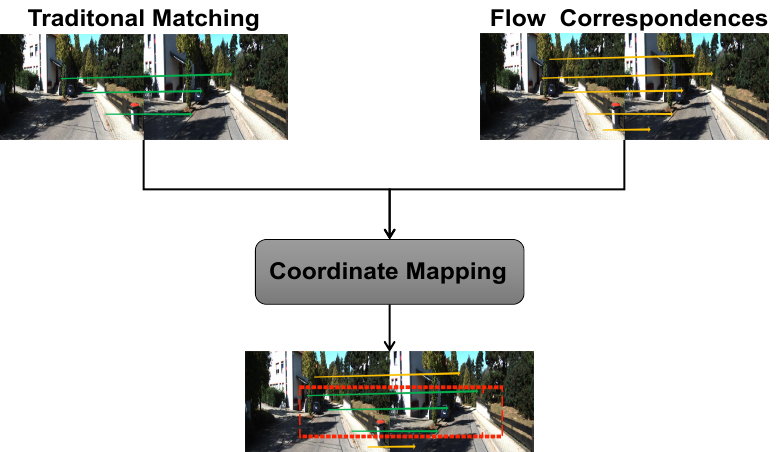
Figure 4. Coordinate mapping. Traditional matching is used as the benchmark, and matching point pairs are selected by coordinate